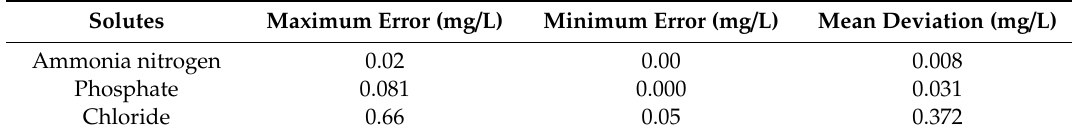
Table 5. Comparison of fitted concentration and standard